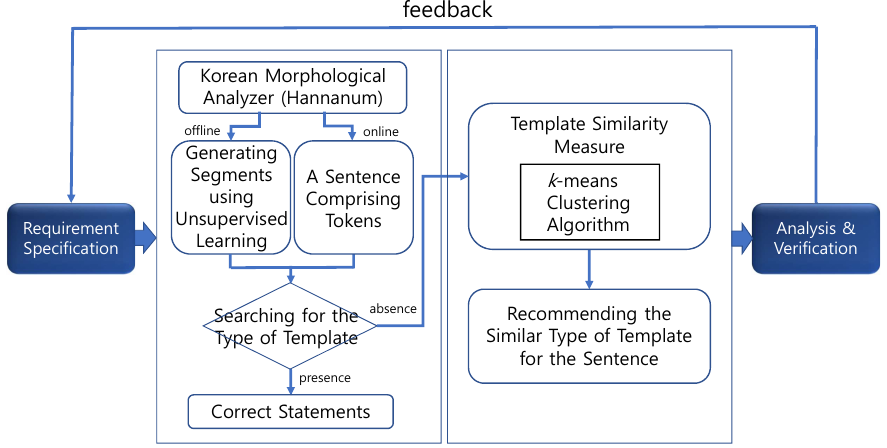
Figure 1. The overall validation process used to prove the correctness of a requirement